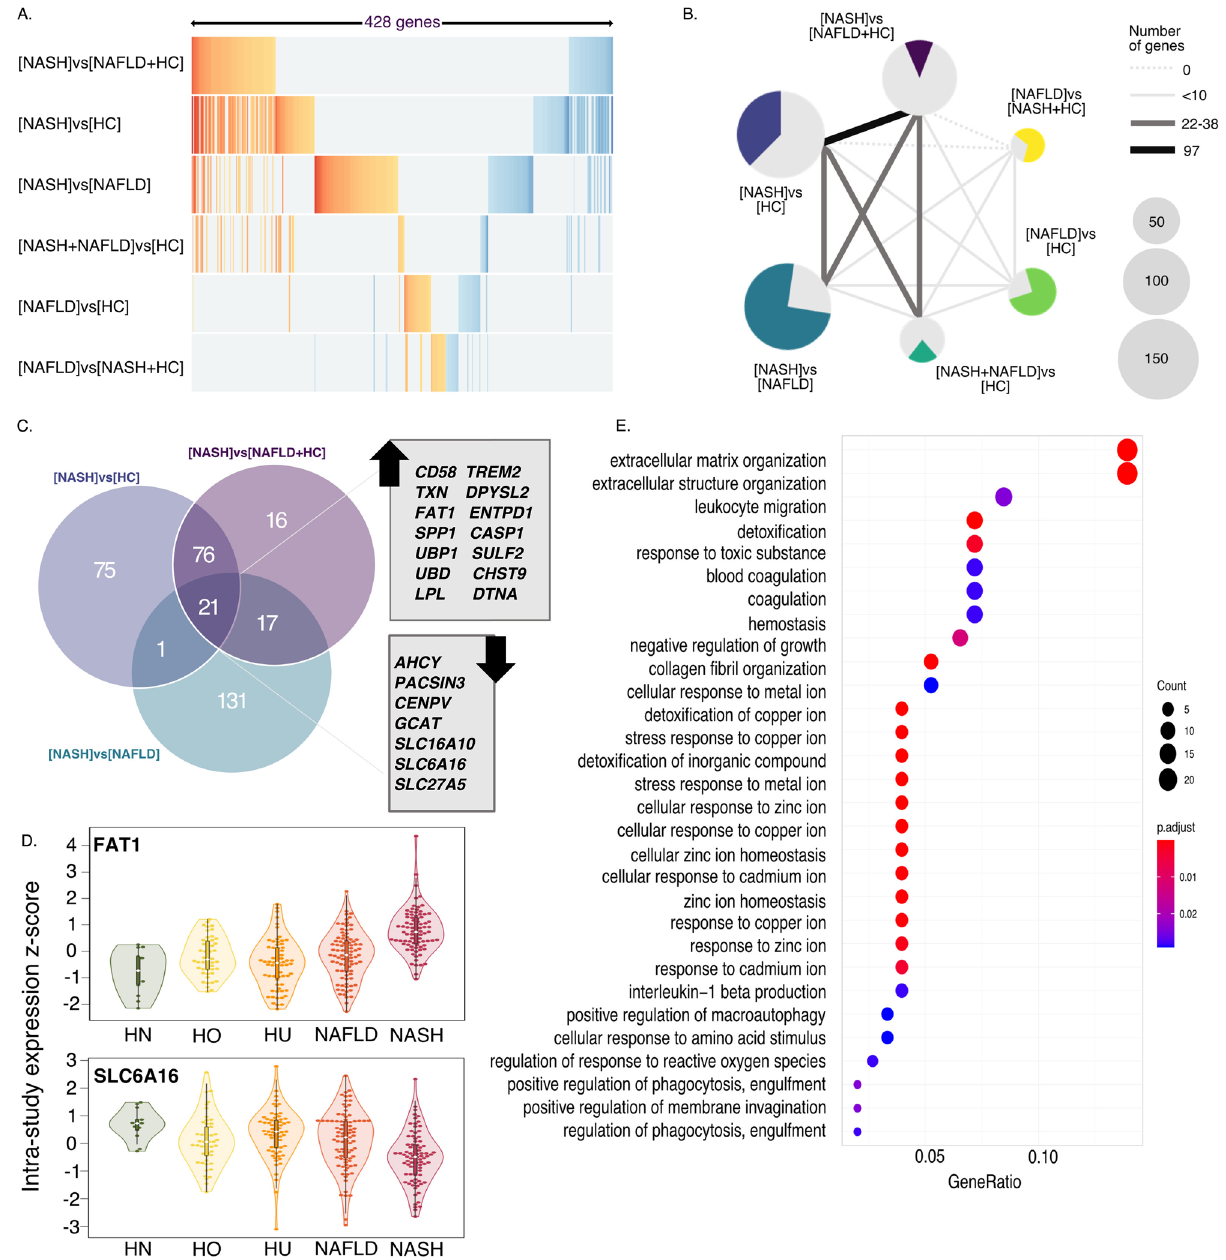
Figure 2. NASH signature gene composition. ( A ) ES of union of all genes (n = 428) in each signature. ES of genes that are not significant for the particular signature were coded as 0 (grey). ( B) Each signature is represented by a pie chart. Number of genes in each signature is represented by pie size, colored part of the chart represents proportion of genes that are unique to the relevant signature. Thickness of the lines represent number of genes shared by each pair of signatures (as in legend). (C) Overlap of [NASH]vs[NAFLD + HC], [NASH] vs[NAFLD] and [NASH]vs[HC] signatures. Genes common to all three signatures (n = 21) are listed according to their direction of change (up or down) in [NASH]vs[NAFLD + HC] signature. ( D ) Violin plots of zscores of expression of 2 representative genes (FAT1 for over-expressed and SLC6A16 for under-expressed) listed in C. Groups are color coded based on classification (HN = healthy normal BMI, HO = healthy obese, HU = healthy unknown BMI, NAFLD and NASH). In analysis all healthy were considered as one group, regardless of BMI status. ( E) Pathway enrichment analysis of [NASH]vs[NAFLD]